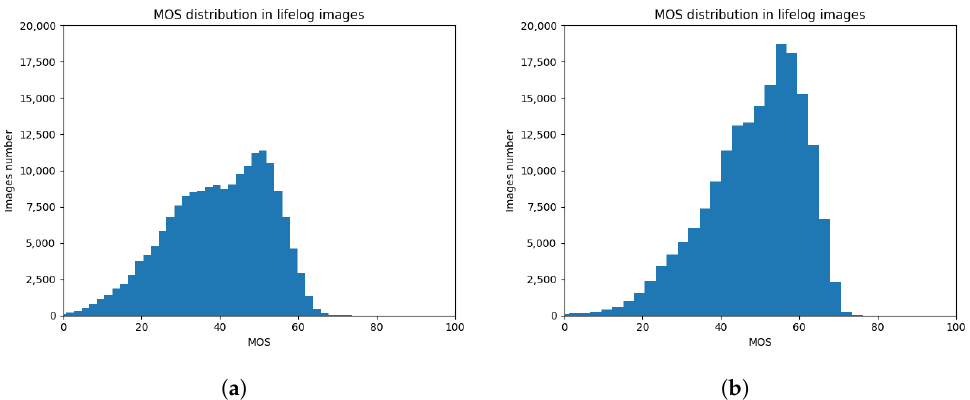
Figure 2. MOS distribution predicted on a lifelog dataset using the pre-trained KonCept512 models: ( a ) provided by Hosu et al. [9] and ( b ) trained in this